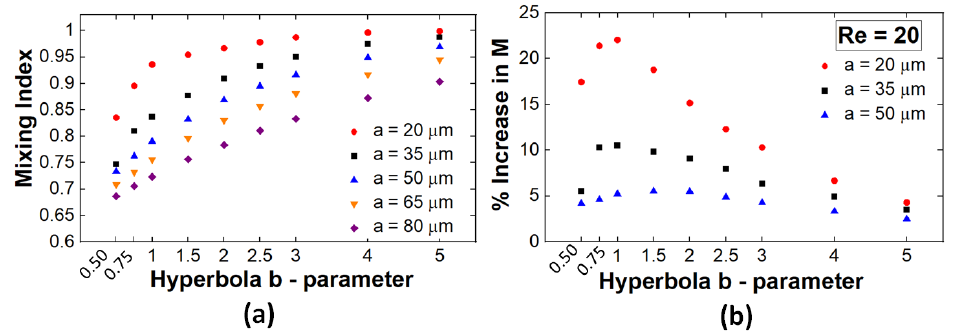
Figure 9. ( a ) Parametric study of the mixing index dependence on the a and b parameters ( Re = 20); ( b ) increase in the mixing performance relative to simple serpentine designs. ( b ) increase in the mixing performance relative to simple serpentine